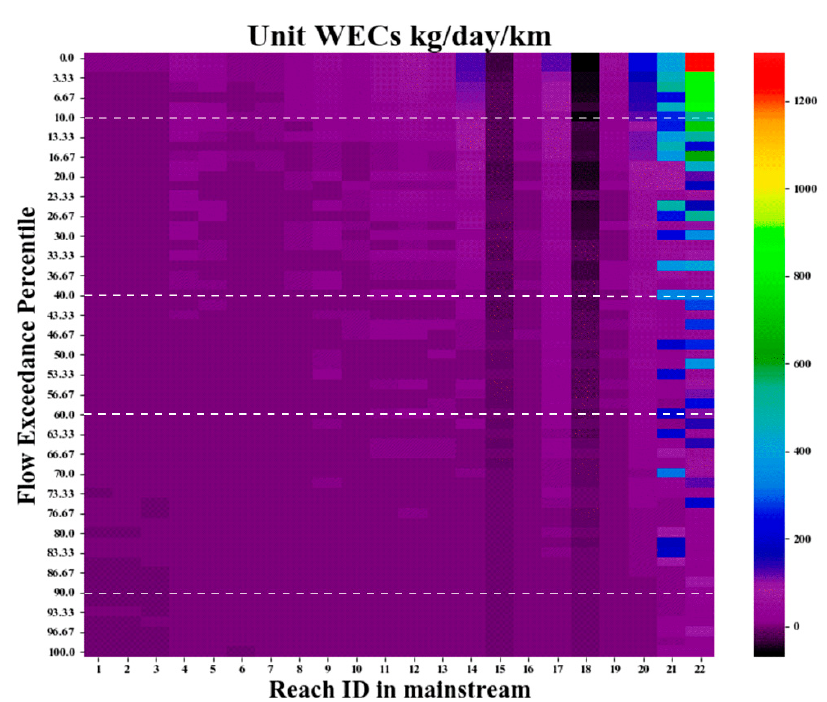
Figure 10. Estimation of unit WEC (kg/d/km) under different flow regimes in Luanhe Mainstream.